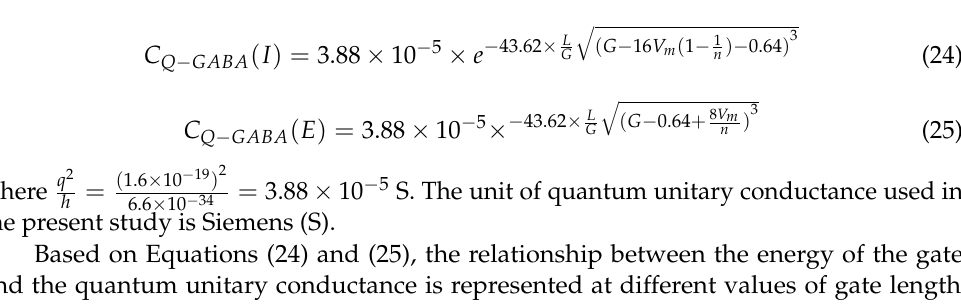
Figure 4. ( a , b ): The figure represents the relationship between the energy of the gate G and the common logarithm of the tunneling probability of the intracellular chloride ions log the tunneling probability of the extracellular chloride ions relationships are investigated at different values of gate length and according to the setting values above each figure.